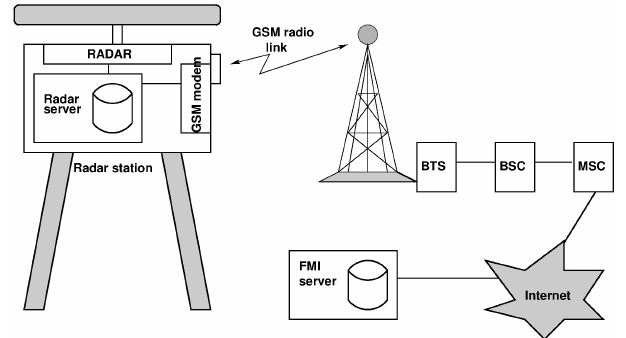
Figure 1. Coastal radar and data transmission. The temporal me- dian filtering is performed on the radar server; a PPI radar image is transmitted every 2min by the GSM modem through the GSM base transceiver station (BTS), GSM base station controller (BSC), and mobile switching centre (MSC) and further through the Internet and to the FMI server performing the radar motion